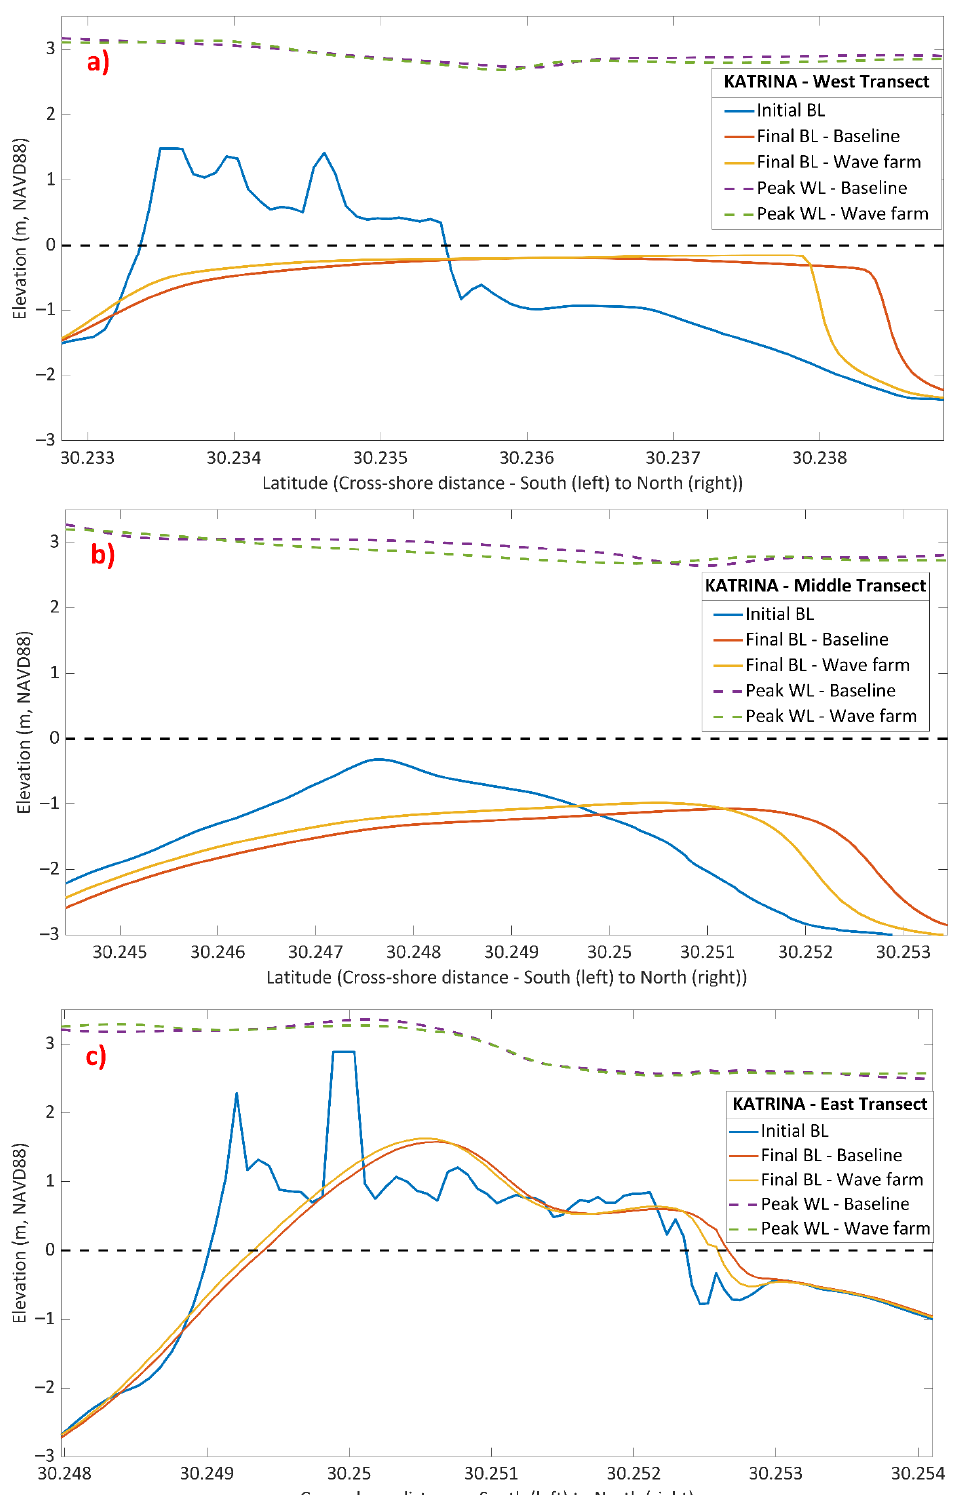
Figure 10. Hurricane Katrina bed levels (BL) and water levels (WL) at the west ( a ), middle ( b ), and east ( c ) transects on Dauphin Island, AL under baseline and wave farm scenarios. Note that the figures are zoomed in for readability. Initial WL is at the zero level for all transects. Black dashed line shows the 0 m elevation.